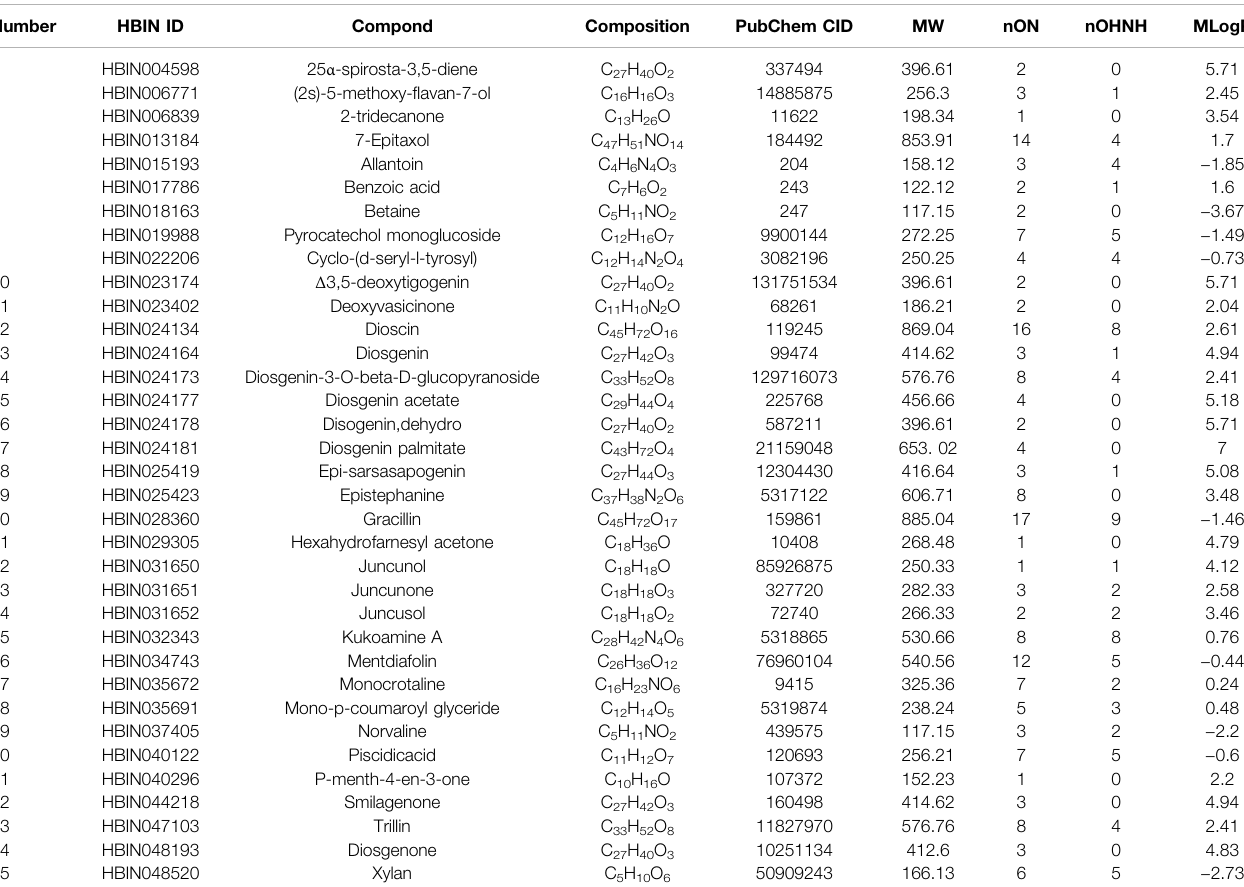
TABLE 1 | Chemical information for the active compounds of